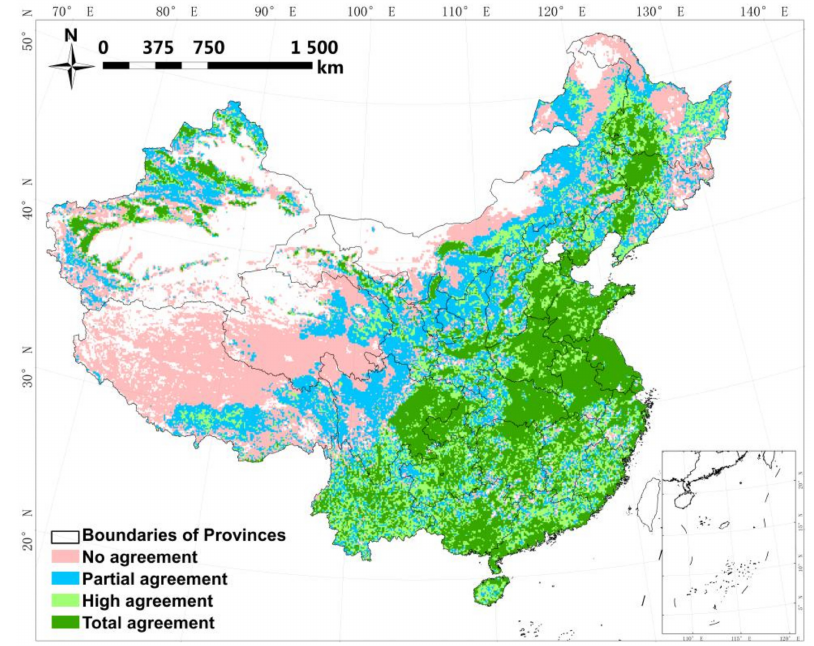
Figure 4. Spatial agreement of datasets. No agreement means a grid is considered as irrigated by only one dataset, whereas partial, high and total agreement means a grid is considered as irrigated by two, three, or four datasets,